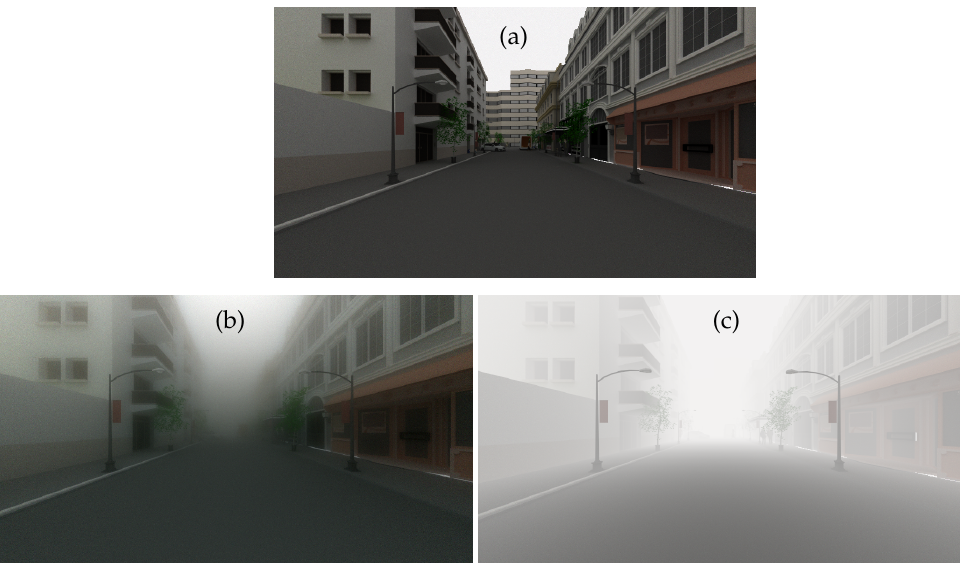
Figure 6. Simulated images for the intra-urban scene with the SWEET simulator without fog ( a ) and with fog (MOR = 20 m, ( b )) and with the Koschmieder model ( c ) in day conditions.